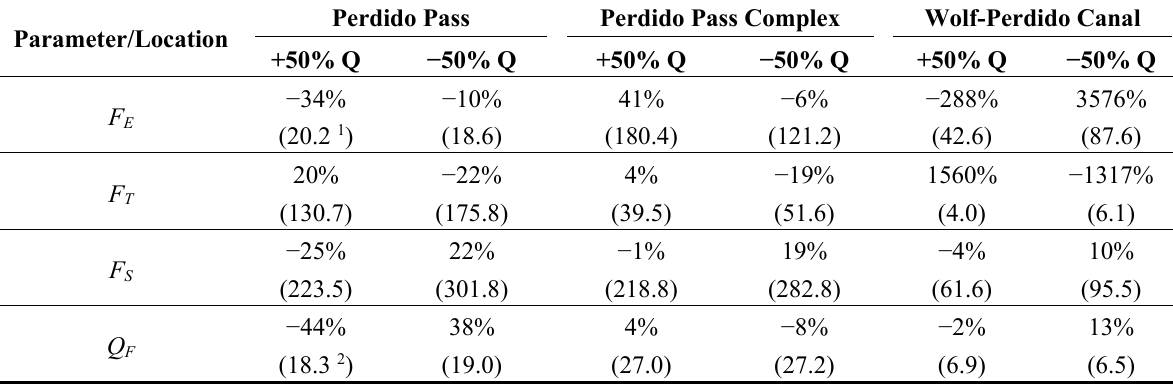
Table 5. Statistical summary of average percent changes (%) and standard deviations of the differences (numbers in the brackets) of exchange parameters between sensitivity model runs and the calibration run at Perdido Pass, Perdido Pass complex, and Wolf-Perdido canal. The “+50% Q” and “ − 50% Q” represent the 50% increase and decrease of freshwater inflows from all upstream rivers form the calibration run, respectively. Perdido Pass Perdido Pass Parameter/Location